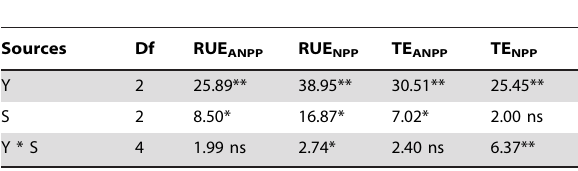
2006. RUE ANPP was higher in 2004 compared to 2006 but RUE NPP showed the opposite results by being higher in 2006. Transpiration efficiency (TE ANPP ) varied from 0.83 to 1.90 g m 2 2 mm 2 1 and showed no significant interaction between year and site (Table 3, 5). TE ANPP of site HG was significantly higher than that of sites UG79 and WG, while there was no significant difference between sites UG79 and WG. TE ANPP in 2005 was significantly higher than that in 2004 and 2006. Although TE ANPP in 2006 tended to be higher than it was in 2004, there was no significant difference between the two years. TE NPP varied from 1.47 to 4.56 g m 2 2 mm 2 1 and showed significant interaction between year and site (Table 3, 5). TE NPP was not significantly different among three sites in 2004, while TE NPP of site HG was significantly higher than that of sites UG79 and WG. The dry year 2005 significantly increased TE NPP at all sites compared to the years 2004 and 2006. A strong correlation between RUE ANPP and TE ANPP existed at sites UG79 and WG (UG79: R 2 = 0.9446, P , 0.0001; WG: R 2 = 0.9387, P , 0.0001), while the correlation between RUE ANPP and TE ANPP at site HG ( R 2 = 0.4750, P = 0.004) was not as strong and RUE ANPP can only explain 47.5% variation of TE ANPP (Figure 3). However, the correlation between RUE NPP and TE NPP was significantly improved when the calculation was based on total net primary productivity at site HG ( R 2 = 0.8055, P , 0.0001), and RUE NPP explained the 80.55% variation of TE NPP (Figure 4). At sites UG79 and WG transpiration efficiency was only slightly improved (UG79: R 2 = 0.9542, P , 0.0001; WG: R 2 =0.9626, P , 0.0001) when the whole plant production was included (Figure 4). We found a strong positive correlation between litter amount and the ratio of plant transpiration to evapotranspiration (T/ET) in all three years (2004: R 2 = 0.82, P , 0.0001; 2005: R 2 = 0.80, P , 0.0001; 2006: R 2 = 0.75, P , 0.0001) (Figure 5). Land use and Drought Effects on Root Distribution Overall, the distribution pattern of roots along soil profiles showed a similar trend for all sites (Figure 6), that is root biomass decreased with increasing soil depths and most of the roots were allocated in the top soil layer (0–20 cm). However, approximately 60% of the roots were allocated in the first 10 cm at site HG, whereas only approximately 40% of the roots were allocated in the same depth at sites UG79 and WG. Consequently, the relative root allocation to deeper soil layers was significantly lower at site HG than at sites UG79 and WG.